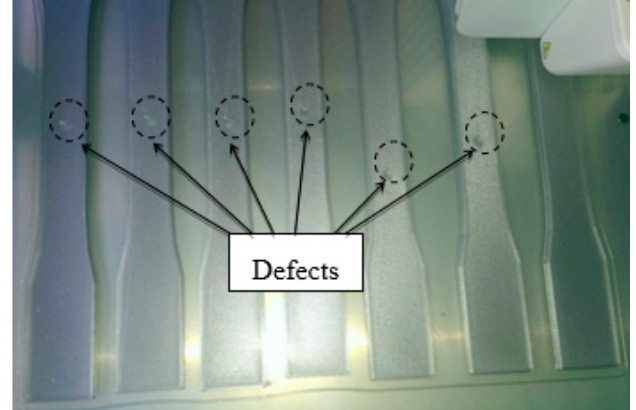
Figure 7. Internal defects captured during the three-dimensional (3D) printing of the grey specimens. J. Manuf. Mater. Process. 2019 , 3 , x FOR PEER REVIEW